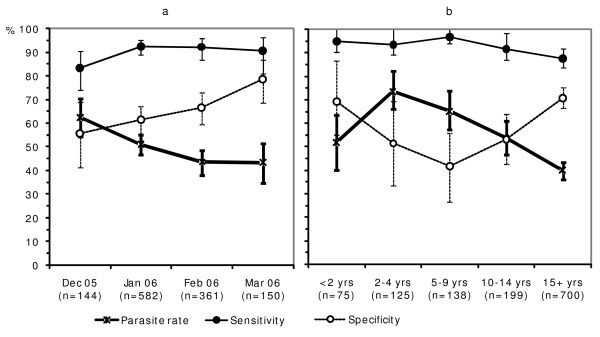
Sensitivity and specificity of RDTs as a function of the true parasite rate (as determined by microscopy) at Kebisoni, Rukungiri District, Uganda, by (a) month and (b) age groups (error bars indicate 95% confidence intervals).